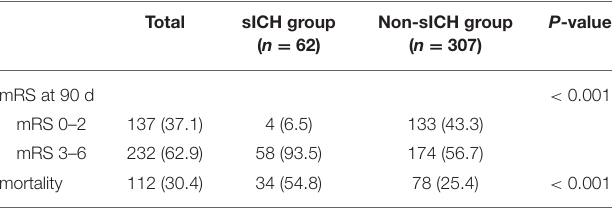
TABLE 3 | Functional outcome at 90 days in sICH and non-sICH